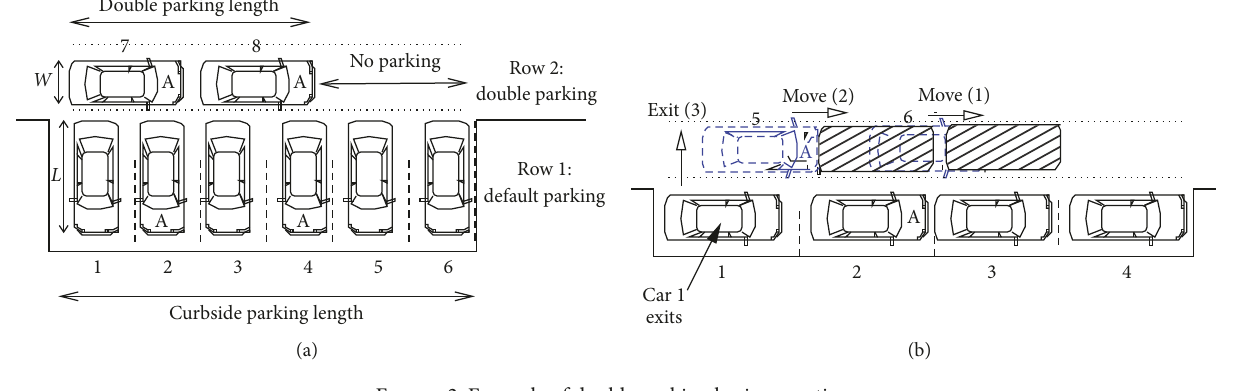
Figure 2: Example of double parking basic operation.